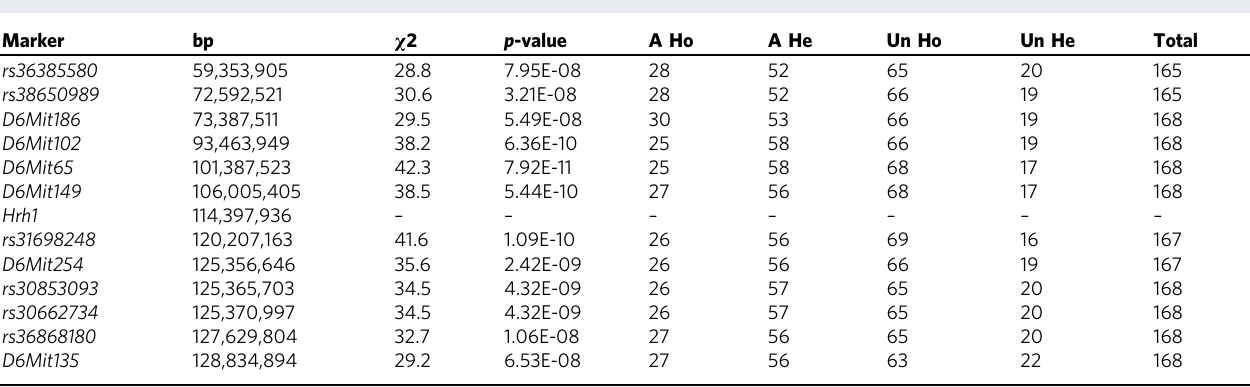
Table 4 Linkage of Chr6 marker loci to Bphse